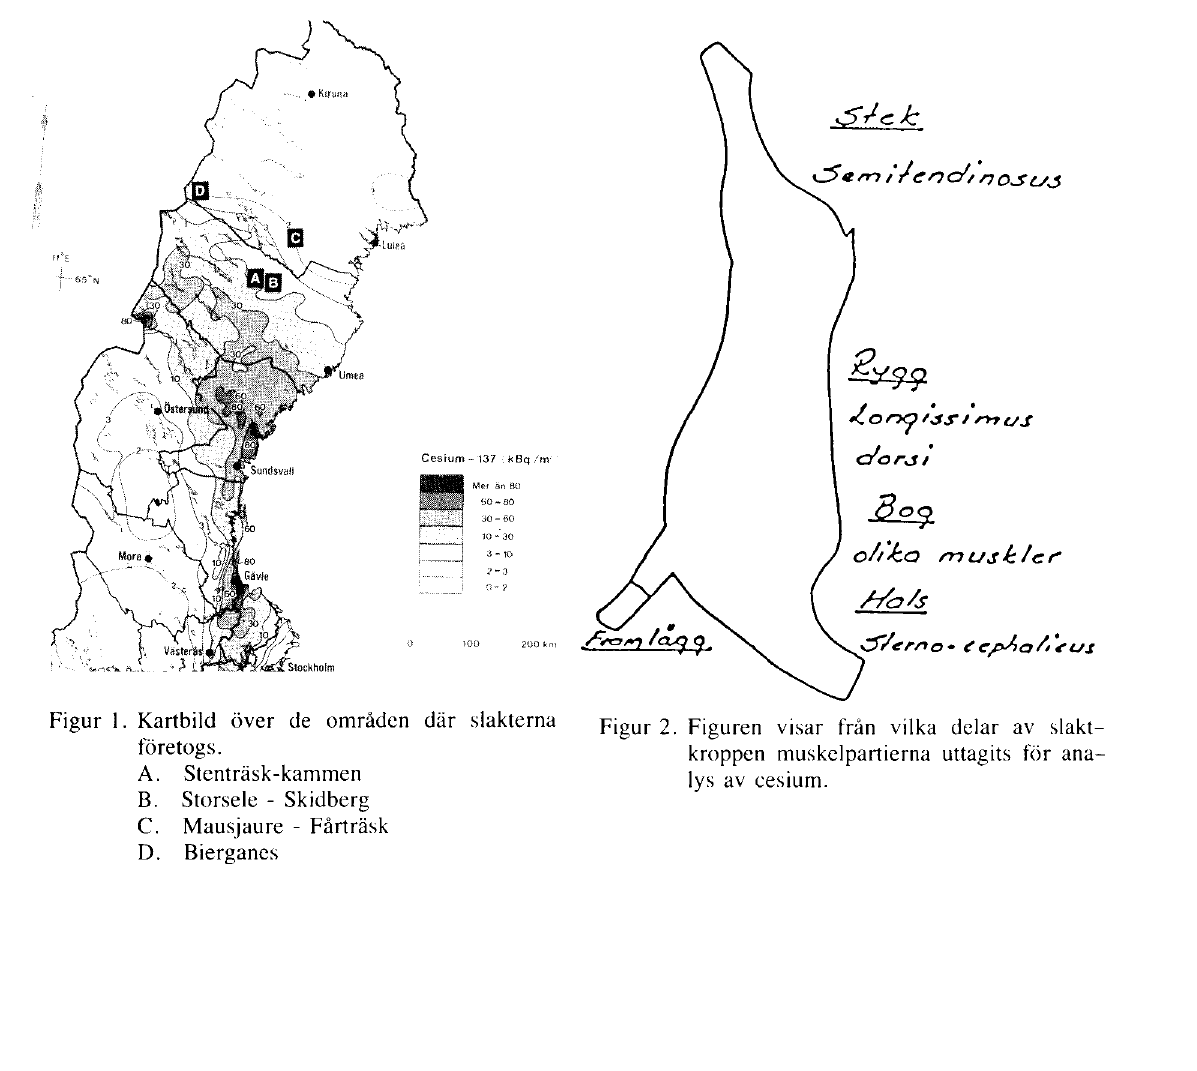
Figur 1. Kartbild over de områden dår slakterna Figur 2. Figuren visar från vilka delar av slakt-